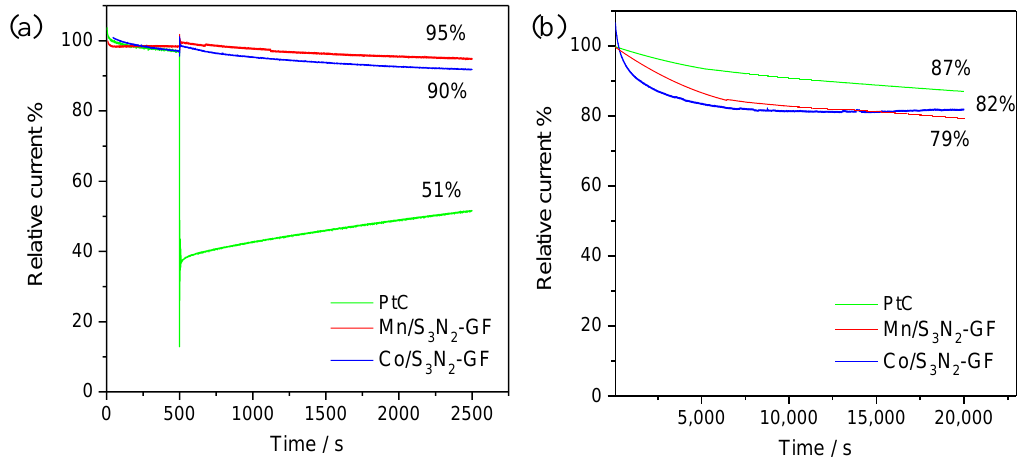
Figure 9. Chronoamperometric responses at E = 0.50 V vs. RHE and 1600 rpm of Pt/C, Co/S 3 N 2 –GF and Mn/S 3 N 2 –GF in 0.1 mol dm -3 O 2 -saturated KOH with the addition of 0.5 mol dm -3 methanol at t = 500 s ( a ) and without any addition for 20,000 s ( b ).